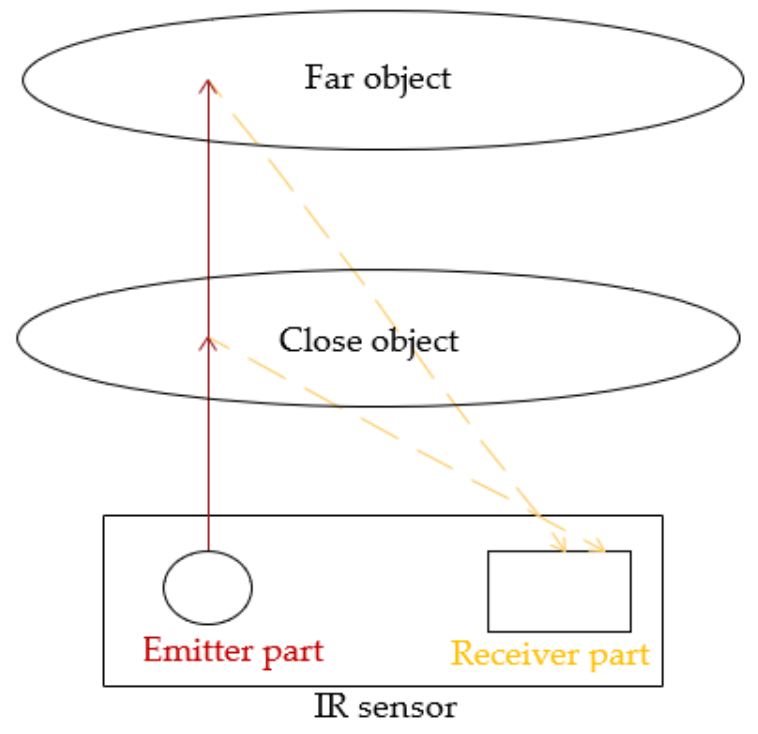
Figure 3. The triangulation procedure of IR